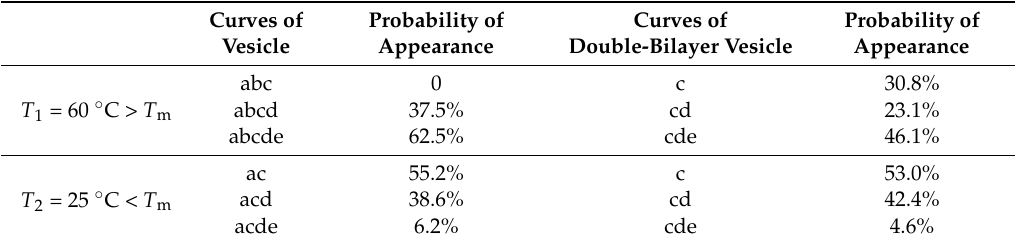
Table 3. Statistical summary of all types of force-distance curves (approach) and corresponding probabilities of appearance for spherical vesicles and double-bilayer vesicles. For each temperature, the data comes from 120 samples (vesicles) which have similar